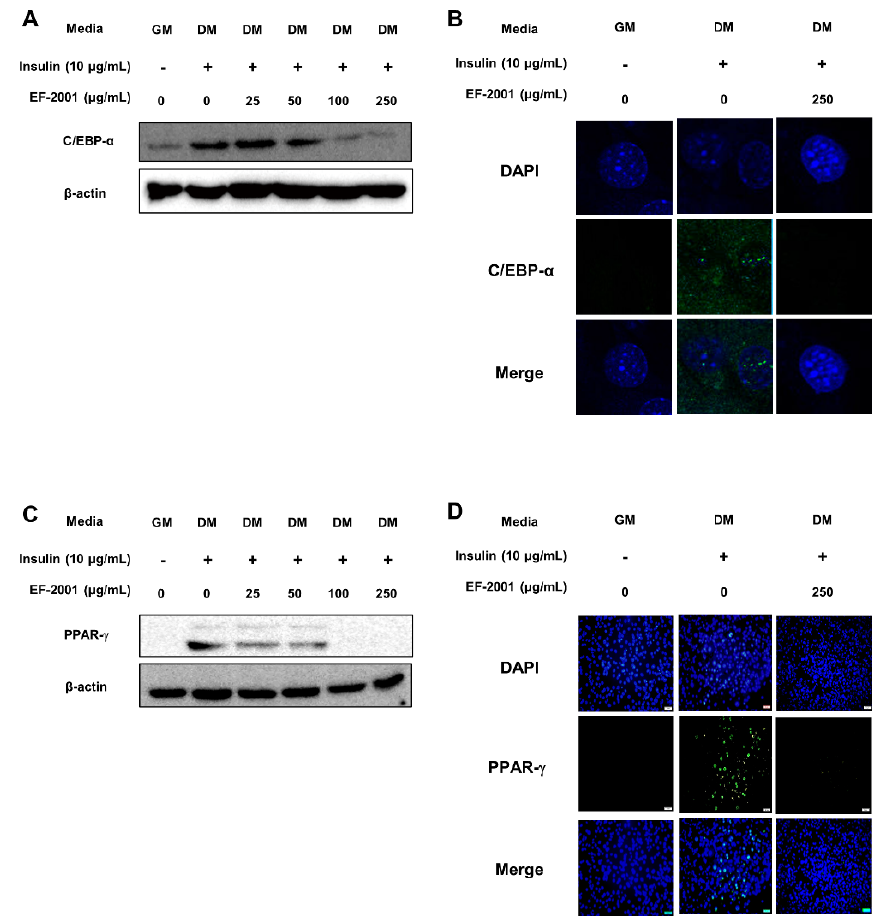
Figure 6. Effects of EF-2001 on the protein expression and nuclear translocation of C/EBP- α and PPAR- γ in 3T3-L1 adipocytes. 3T3-L1 adipocytes were cultured in the absence or presence of EF-